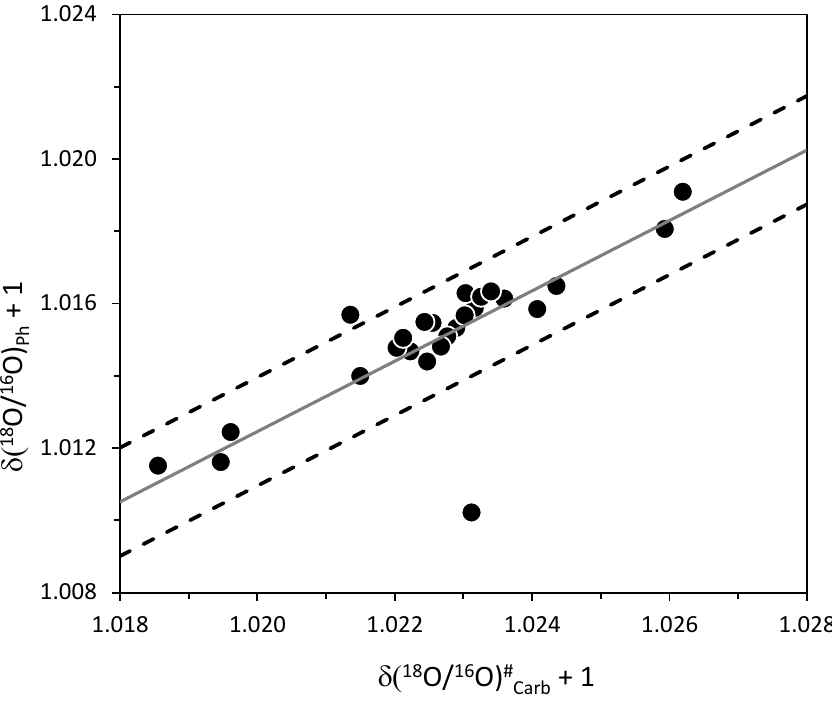
# Figure 2. δ ( 18 O/ 16 O ) + 1 and δ ( 18 O/ 16 O ) + 1 for some Holocen mammal bone remains (Bos and Capra) and from Nile area of Sudan (unpublished data). The two points outside the dotted lines are considered not reliable for archaeological reconstruction. Continuous line represents regression line (11); discontinuous lines define the array ± 1.5‰.